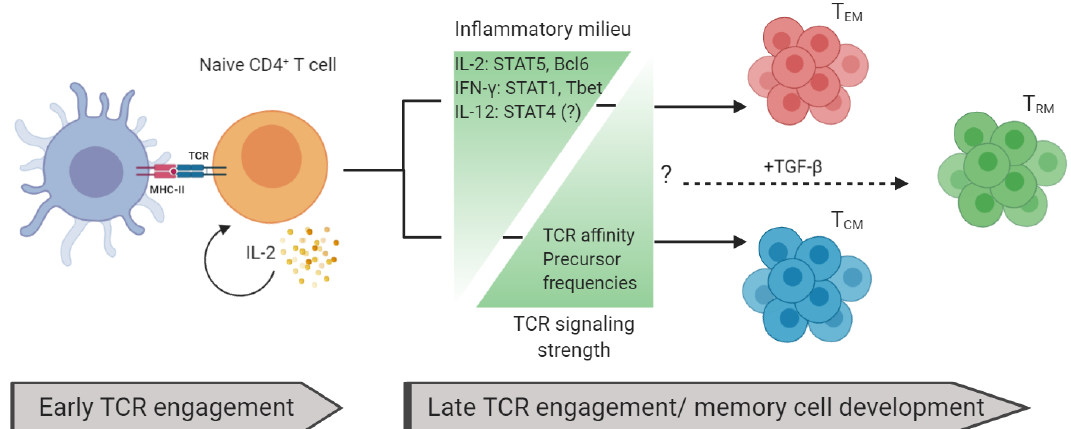
Figure 2. Factors influencing memory T cell development: Naïve T cells are activated by peptide and MHC via TCR. High levels of interleukin (IL)-2 are critical during early TCR engagement for memory- cell development. The memory T cell development fate is dependent on the inflammatory milieu and TCR signaling strength. Increased levels of inflammatory signals favor T EM generation and decreased levels of these signals favor T CM . Conversely, increased levels of TCR affinity and precursor frequencies favor T CM development while decreased levels favor T EM . TGF- β is important for generating T RM. How other inflammatory signals and TCR signaling strength a ff ect T RM generation remains unresolved.